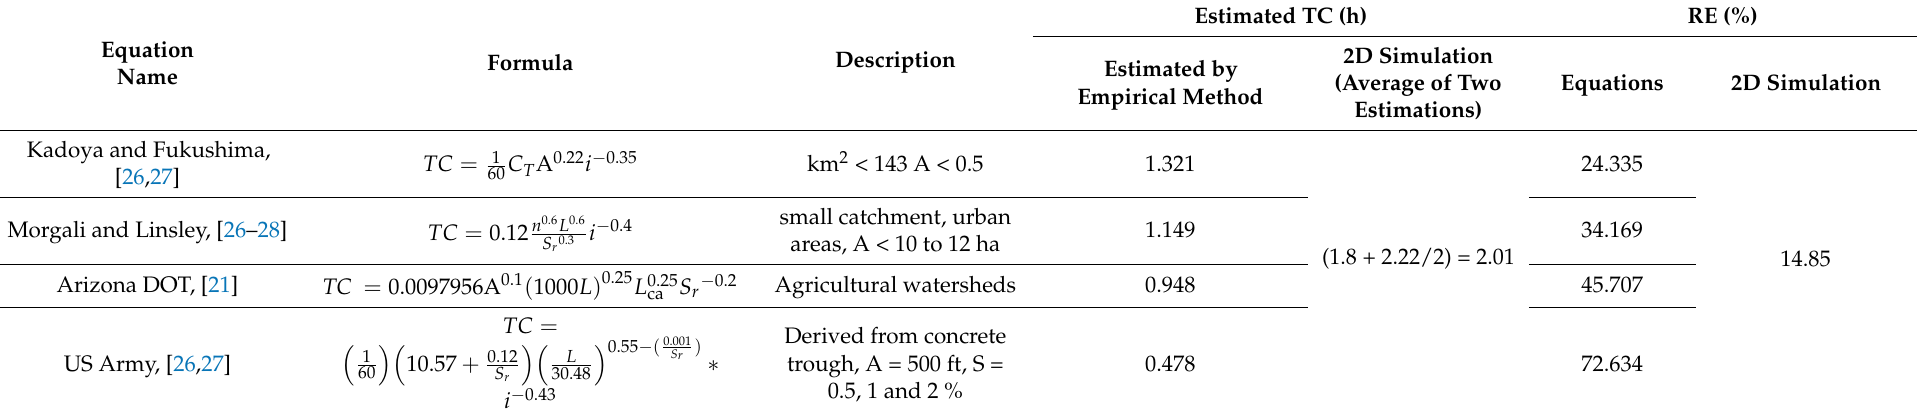
Table 4. TC (h) and RE (%) for methods based on P 24 (category